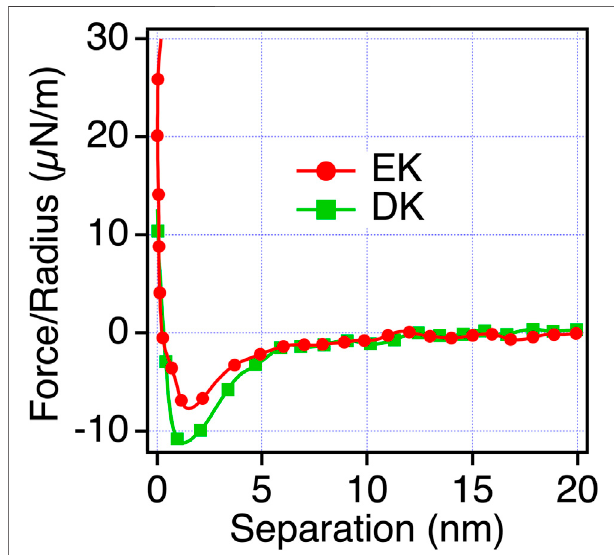
FIGURE 6 | Force-separation curves recorded on an approach for the symmetricsystemoftheEKand DKSAMs(thesameSAMsprepared forboth the probe and substrate) in ethanol and PBS solution [0.23 mol (ethanol)/mol (water)].